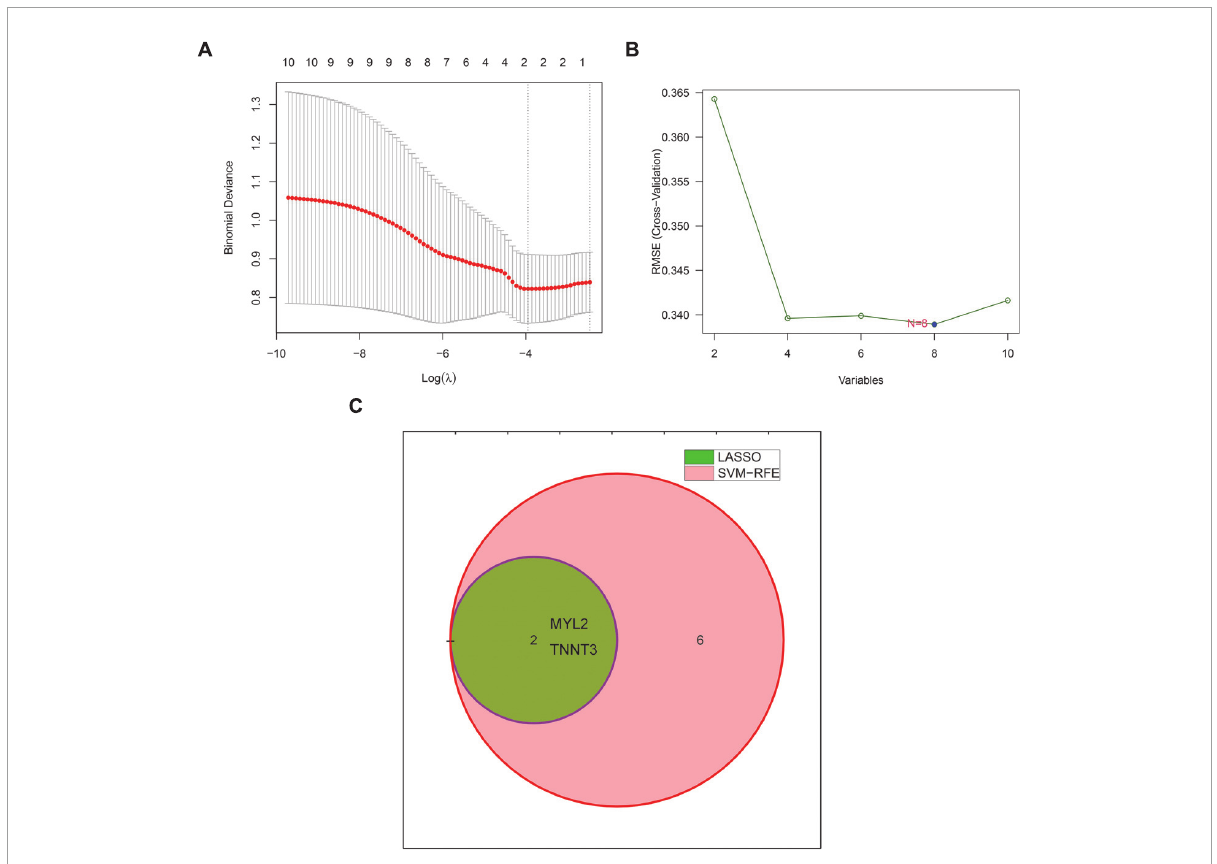
FIGURE3 Machine learning identifies characteristic genes of sudden death. (A) The LASSO regression algorithm was used to select the characteristic genes of sudden death. (B) SVM-RFE algorithm to select the characteristic genes of sudden death. (The blue point represents the lowest error rate, correspondingly to the best genome selected by SVM-RFE). (C) Venn diagram showing 2 sudden death characteristic genes shared by LASSO (green) and SVM-RFE (pink) algorithms. LASSO, least absolute shrinkage and selector operation. SVM-RFE, support vector machine-recursive feature